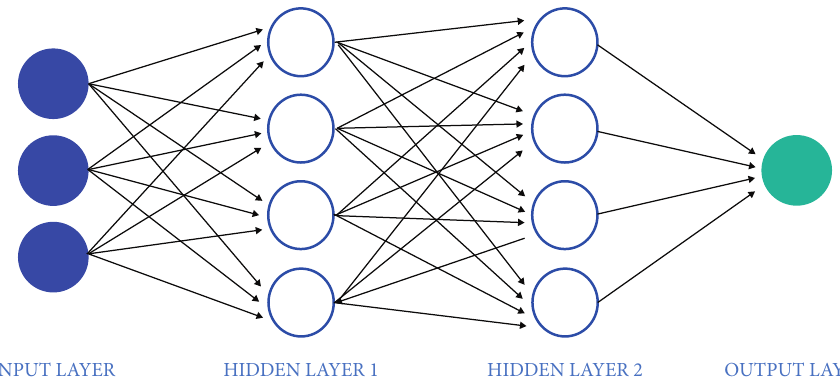
Figure 1: The optimal mapping of the global